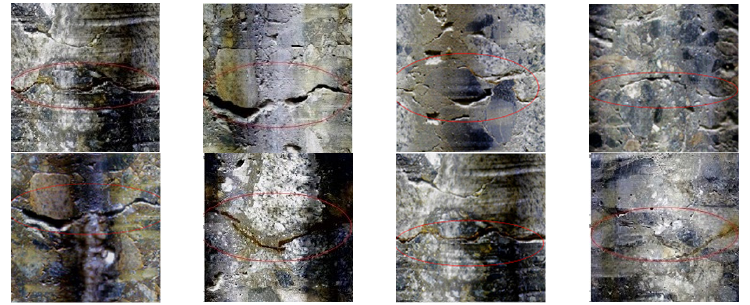
Figure 11. The samples of the dataset.